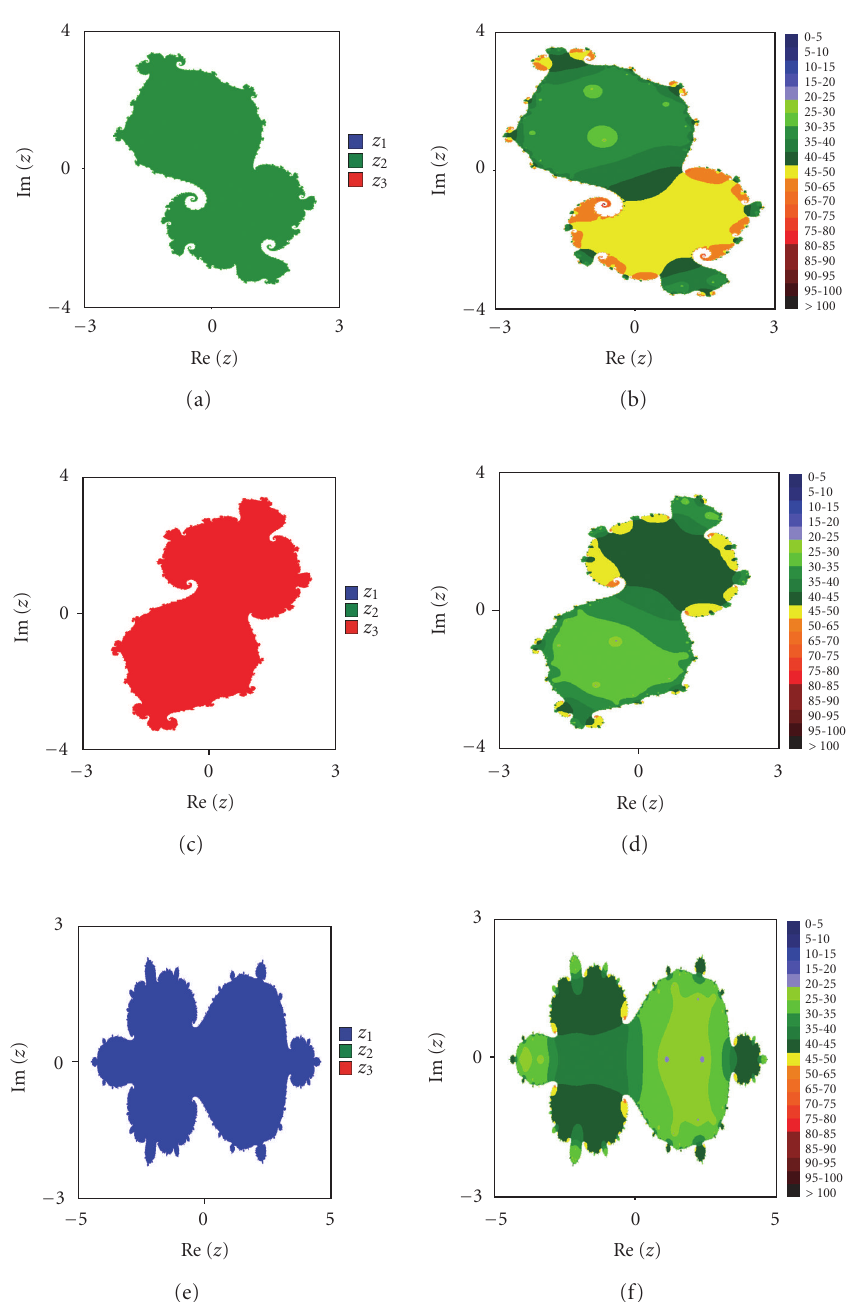
Figure 4.11. Basin of attraction for z 3 − 1 = 0 using GCG method with: (a)–(b) λ = − 0 . 2+ i · 0 . 1 and β = − 0 . 1+ i · 0 . 1, (c)–(d) λ = − 0 . 2+ i · 0 . 1 and β = − 0 . 1 − i · 0 . 1, (e)–(f) λ = β = 0 .